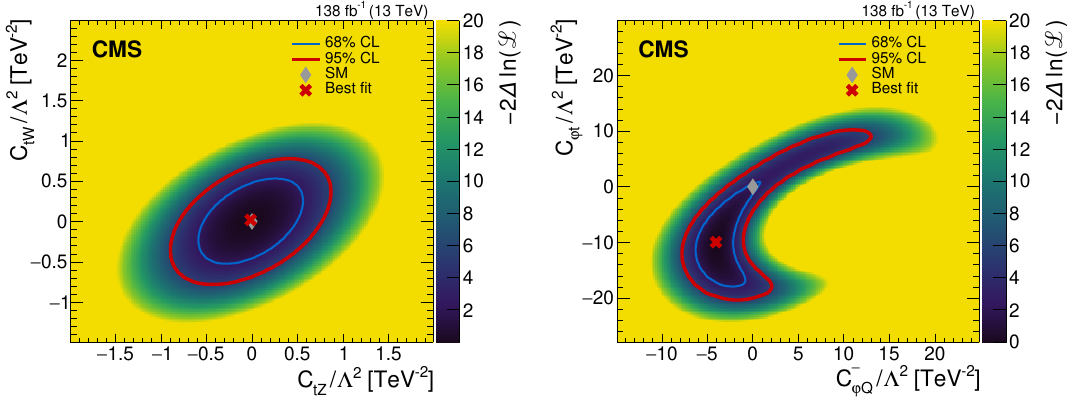
and c (left), tZ tW